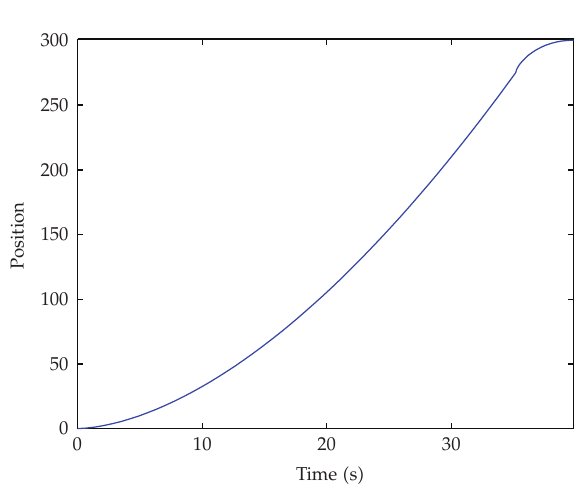
Figure 4: States x (cid:5) t (cid:6) as functions of time t for the Bang-Bang control problem for α (cid:7) 0 . 7.